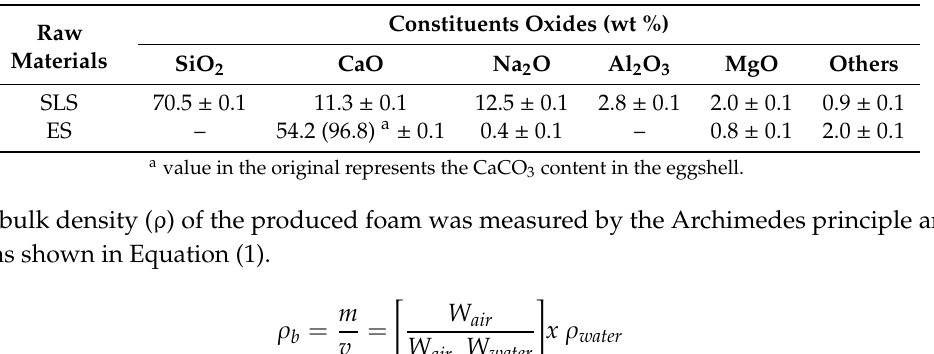
Table 1. Chemical composition of SLS glass and ES.